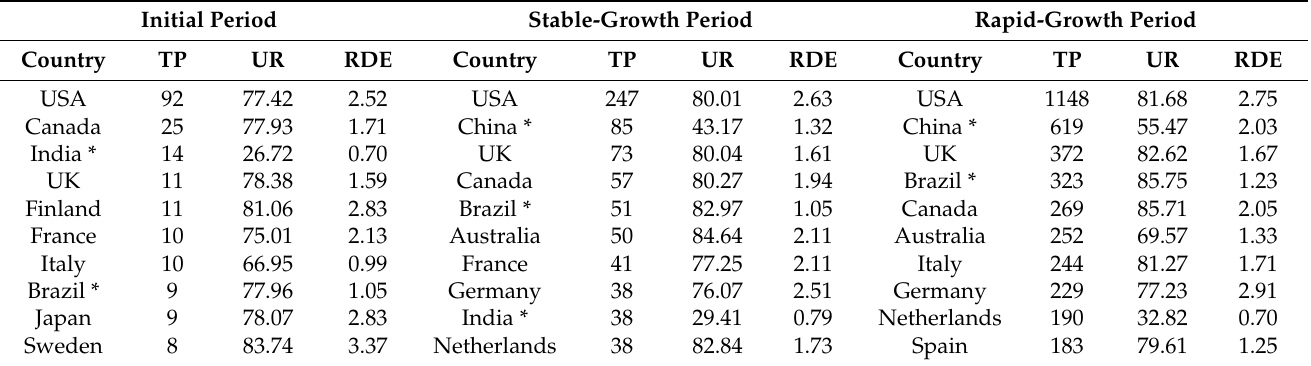
Table 1. The top 10 most productive countries/regions over the three periods.